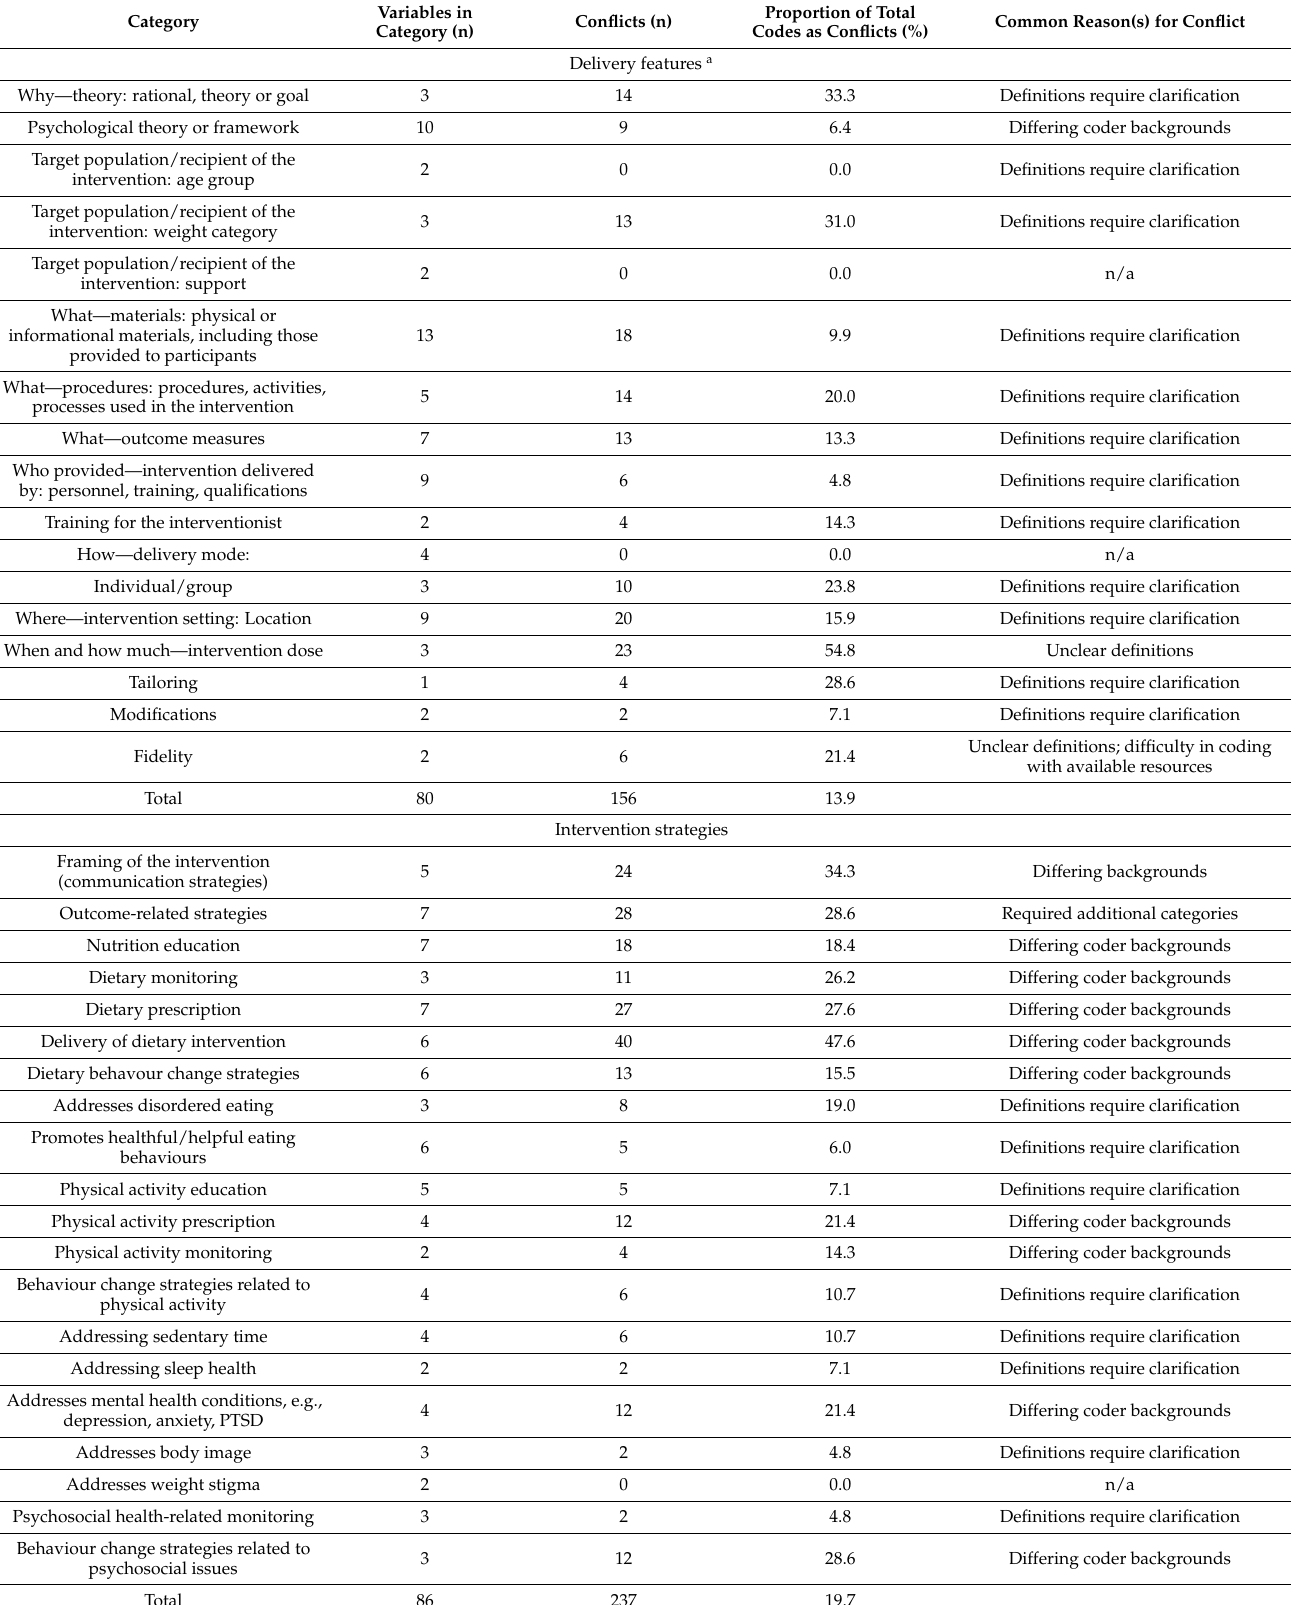
Table 1. Summary of conflicts across clusters of intervention